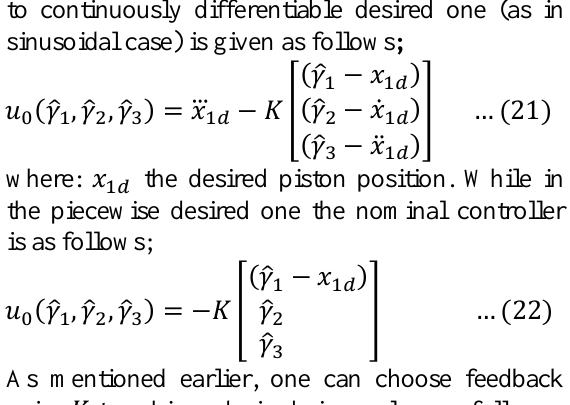
(cid:157) (cid:158)